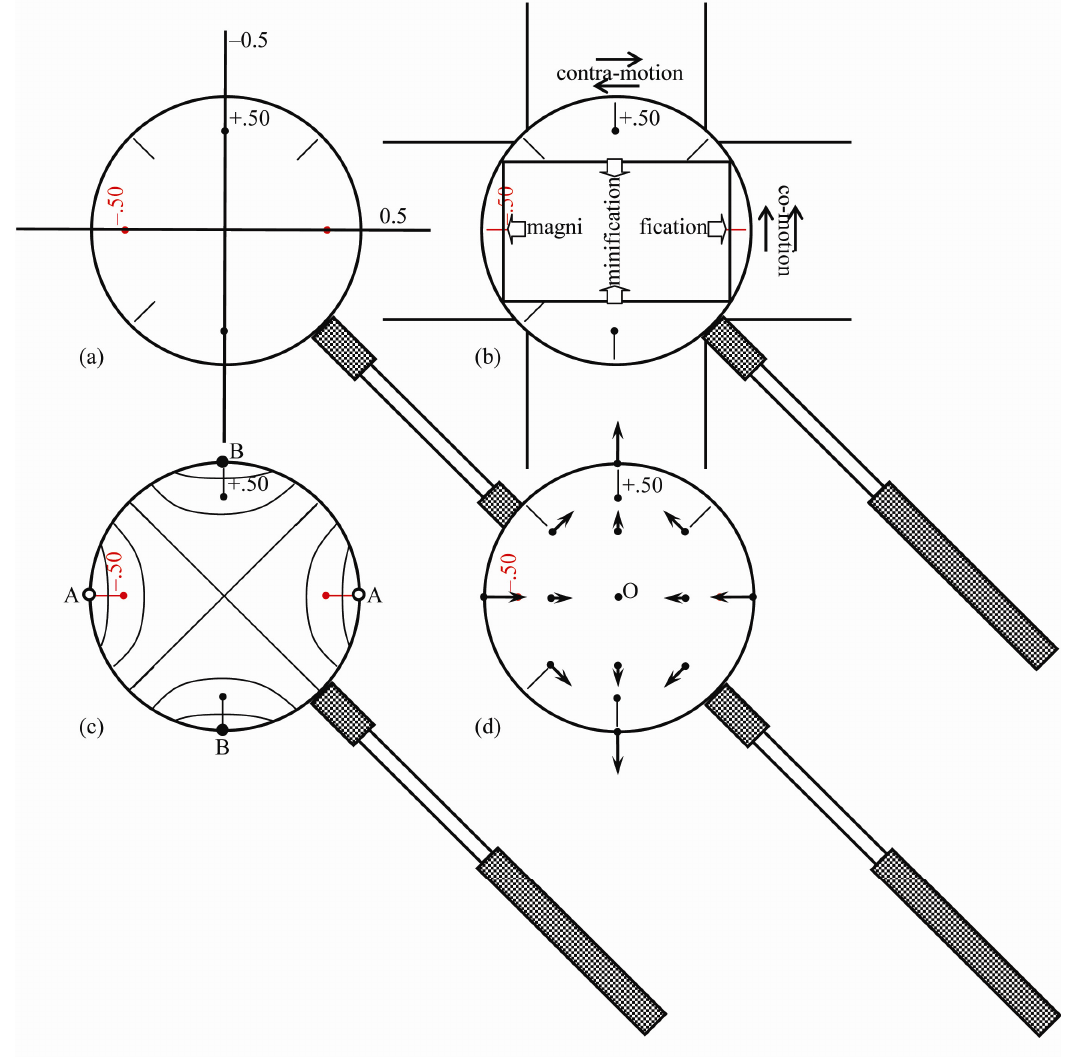
Figure 4 Some properties of the Jackson cross-cylinder in Figure 1. (a) The principal meridians (horizontal and vertical) of the lens and the principal powers along them. Notice that the principal power along the horizontal meridian is 0.5 D. That is in contrast to the fact that the horizontal is labelled – 0.5 on the lens. (b) Objects viewed through the lens appear magnified horizontally and minified vertically. Objects exhibit apparent contra-motion when the lens is displaced horizontally and co-motion when the lens is displaced vertically. (c) Approximate lines of constant thickness of the lens. The lens is thinnest at points A and thickest at points B (compare Figure 3). Equations are presented in the Appendix. (d) The approximate deflectance (prismatic effect) vector field for the lens. O is the optical centre; it coincides with the geometrical centre. On the axis of the handle the deflectance is orthogonal to the handle. Equations are presented in the